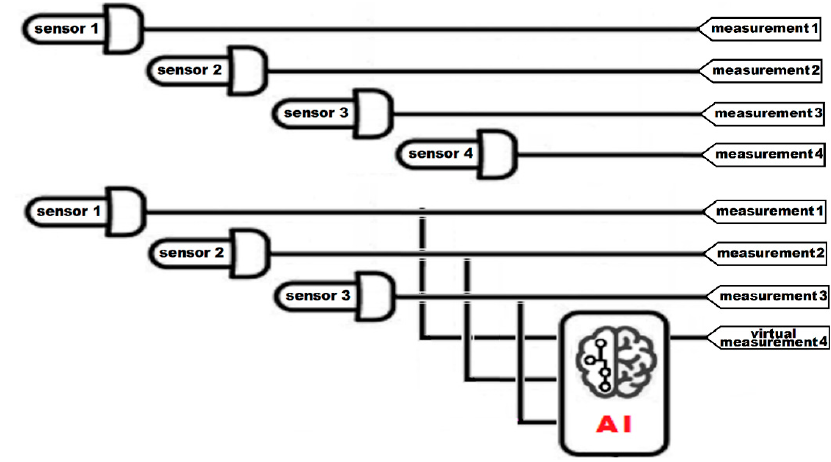
Figure 3. Transition from physical to virtual sensor.